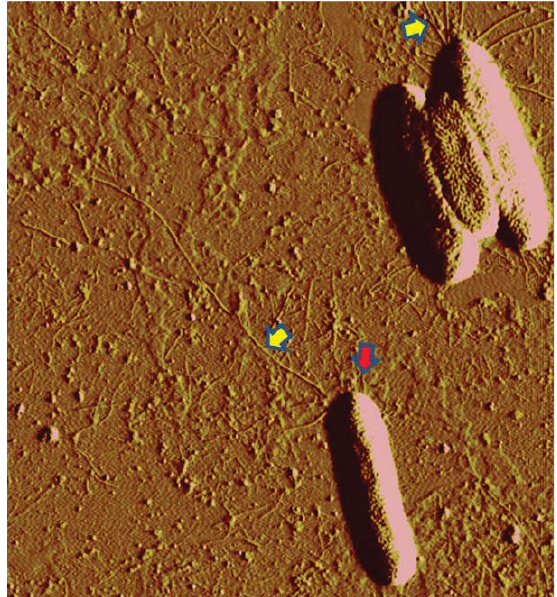
Figure 3. Atomic force micrograph of Xylella fastidiosa “ Temecula ” wild-type cells. Yellow arrows indicate T4P, while red arrows indicate shorter type I pili. Both types of pili are present at the same cell